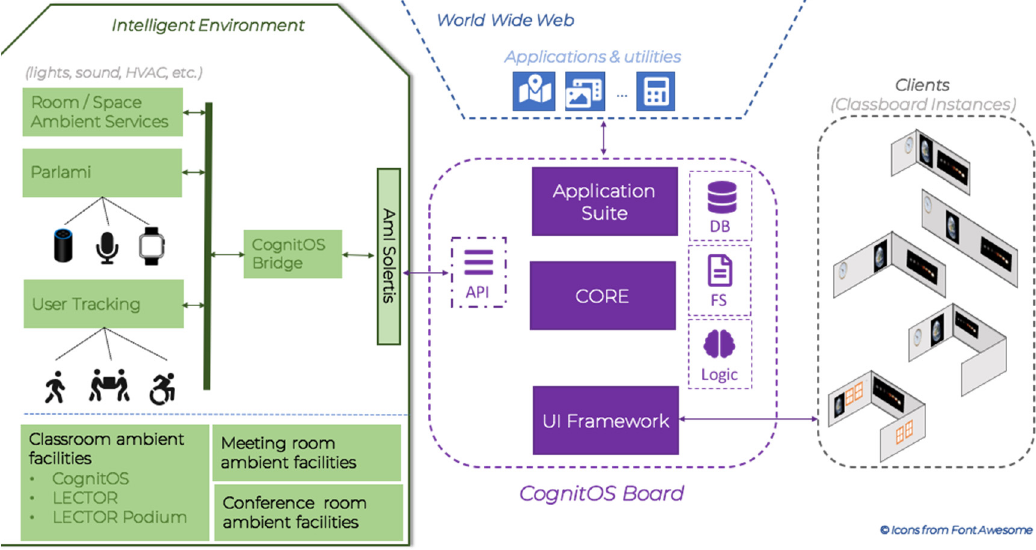
Figure 3. Overview of the CognitOS Board architecture at a software level.